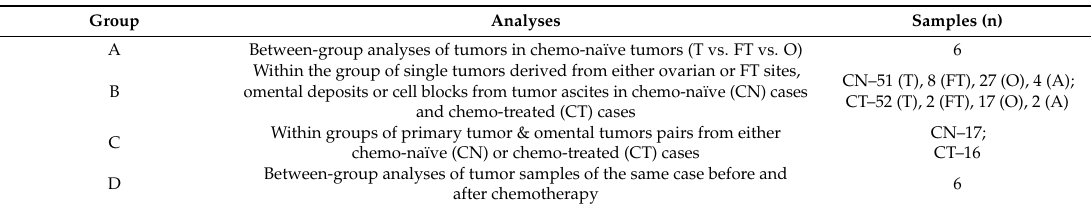
Table 2. Distribution of clinical cohort in tumor